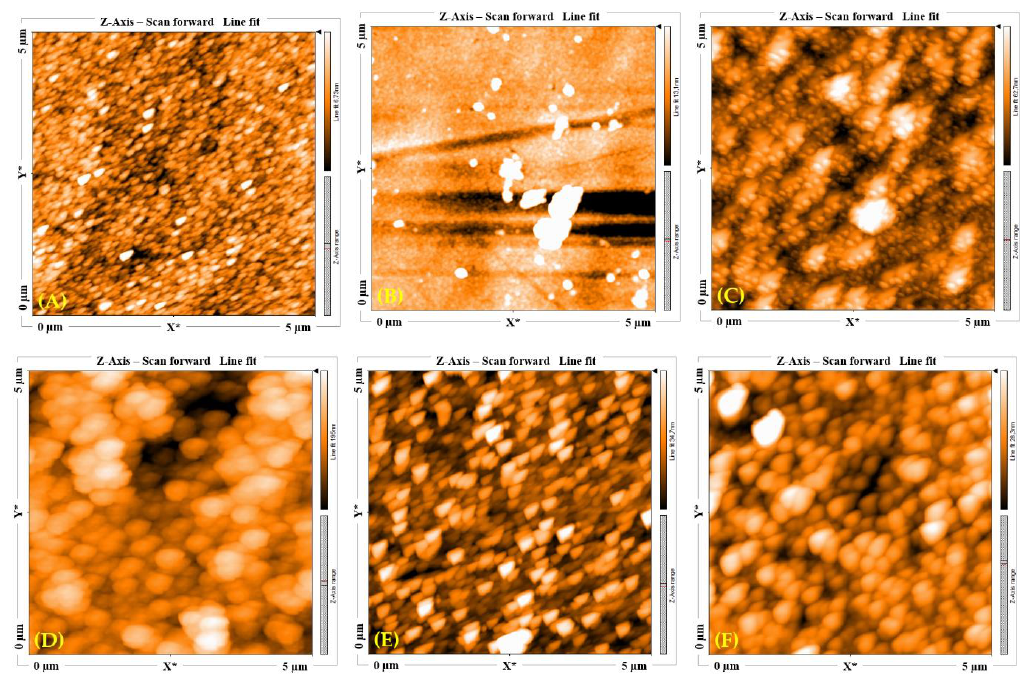
Figure 6. The generated 5 × 5 µm 2 AFM images of ( A ) bare gold electrode, ( B ) gold electrode-diazonium salt, ( C ) Au/Diazo/ZnO nanoparticles, ( D ) Au/Diazo/ZnO nanorods, ( E ) Au/Diazo/ZnO NRs-IIP, ( F ) extracted Au/Diazo/ZnO NRs-IIP.